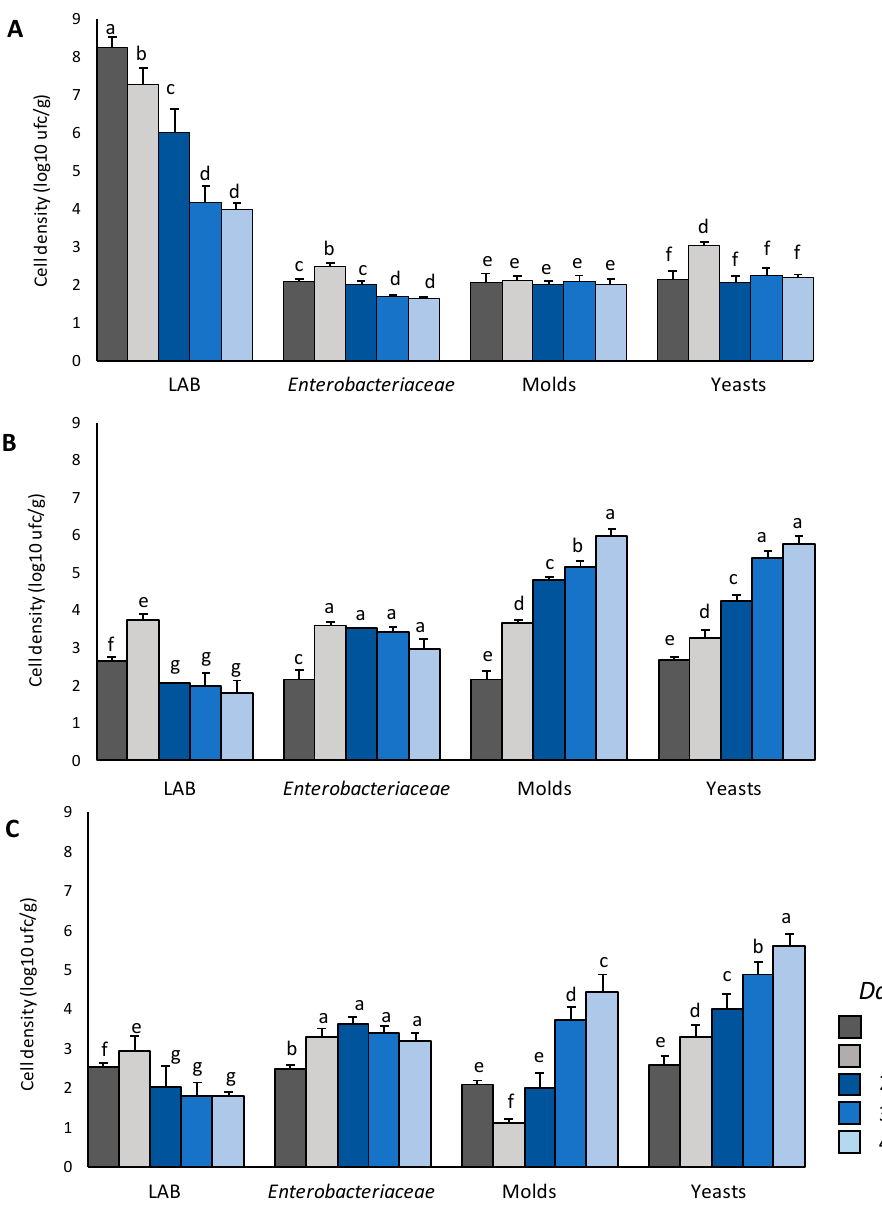
Figure 3. Microbiological analysis of the fresh pasta during a 40-day storage period at 4 ◦ C. Panel ( A ): Semolina fresh pasta fortified with the chickpea sourdough, CS-p; panel ( B ): Conventional semolina fresh pasta CT-p; panel ( C ): Semolina fresh pasta added of 0.3% (w / w on a flour weight basis) calcium propionate, cP-p. LAB, lactic acid bacteria. a – g Values (within the same microbial group and among all the pasta samples) with different superscript letters differ significantly ( p < 0.05). The data are the means of three independent experiments ± standard deviations ( n = 3).